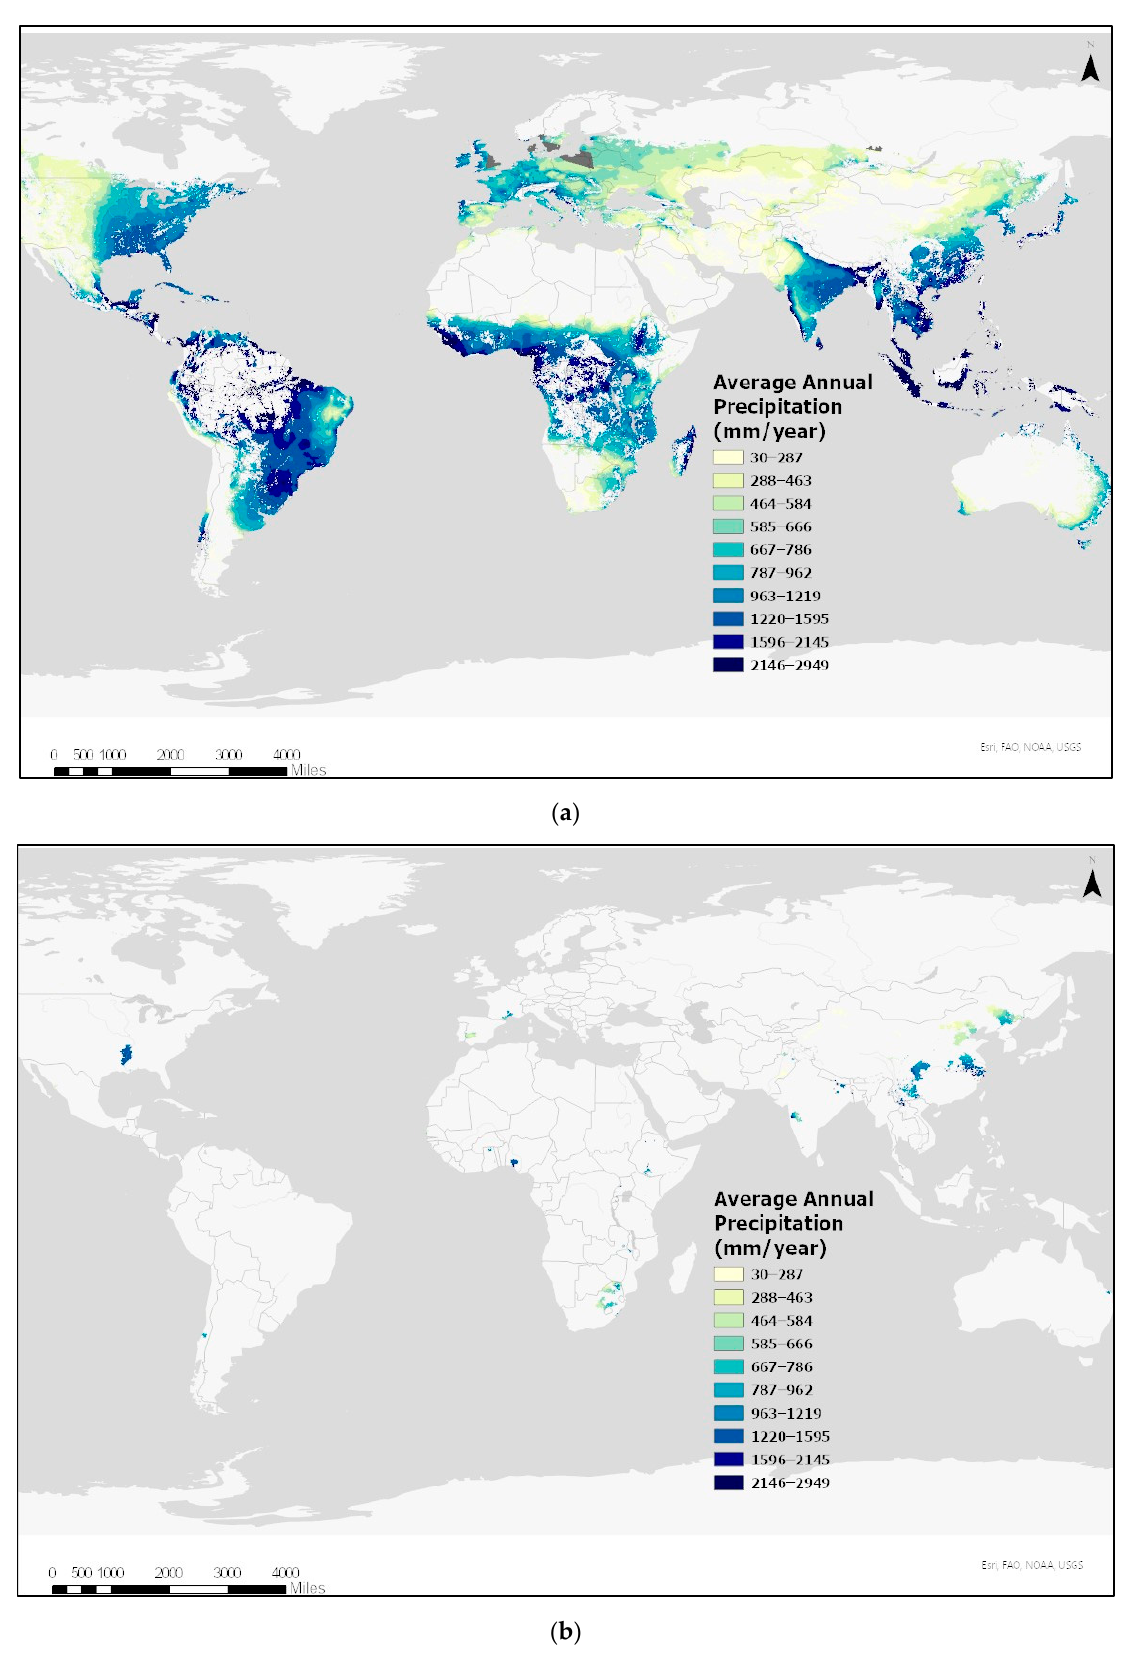
Figure 4. ( a ) Global extent for Avg Annual Precipitation variable. ( b ) Sample extent for Avg Annual Precipitation variable.